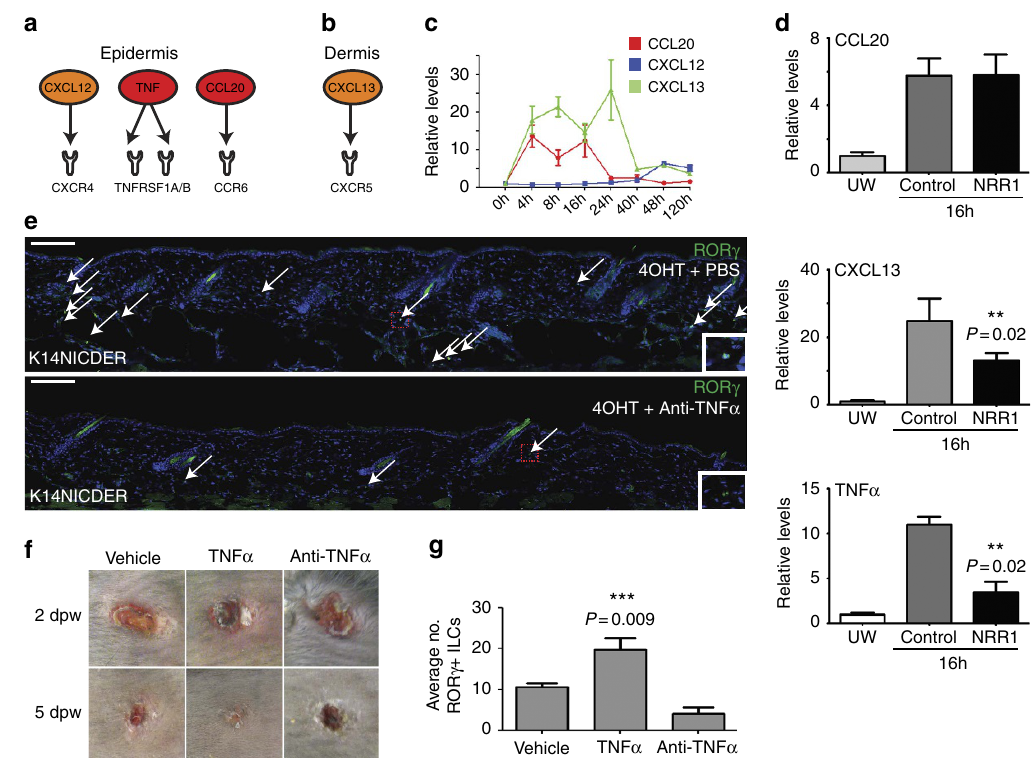
Figure 5 | Notch1 drives expression of TNF a that regulates ILC3 localization in wounds. ( a , b ) Factors upregulated by Notch in the ( a ) epidermis and ( b ) dermis that can interact with receptors expressed on ROR g þ ILCs. ( c ) mRNA levels of CCL20, CXCL12 and CXCL13 quantified by qPCR in unwounded and wounded back skin 4, 8, 16, 24, 40, 48 and 120hrs post wounding. ( d ) qPCR quantitation of CCL20, CXCL13 and TNF a mRNA in unwounded or wounded mice injected with NRR1 blocking antibodies or control IgG antibodies for 7days before wounding and analysed 16hrs after wounding. Graph bars represent mean of biological replicates ( n ¼ 3). ( e ) Back skin sections of K14NICDER transgenic mice injected i.p. with PBS or TNF a blocking antibody for 7days followed by 2days of 4OHT-treatment labelled with antibodies to ROR g (green) and DAPI counterstained. Embedded insets are higher magnification images of the boxed region in the accompanying panel. ( f ) Punch wounds treated with PBS (vehicle), TNF a or TNF a blocking antibody (anti-TNF a ) photographed at 2 and 5 dpw. Note red, inflamed tissues evident adjacent to TNF a -treated wounds 2 dpw. Experiment repeated twice (total animal numbers n ¼ 4 control; n ¼ 7 TNF a blocking antibody; n ¼ 8 TNF a ). ( g ) Quantification of dermal ROR g þ cells in wounded mice 2 dpw treated with